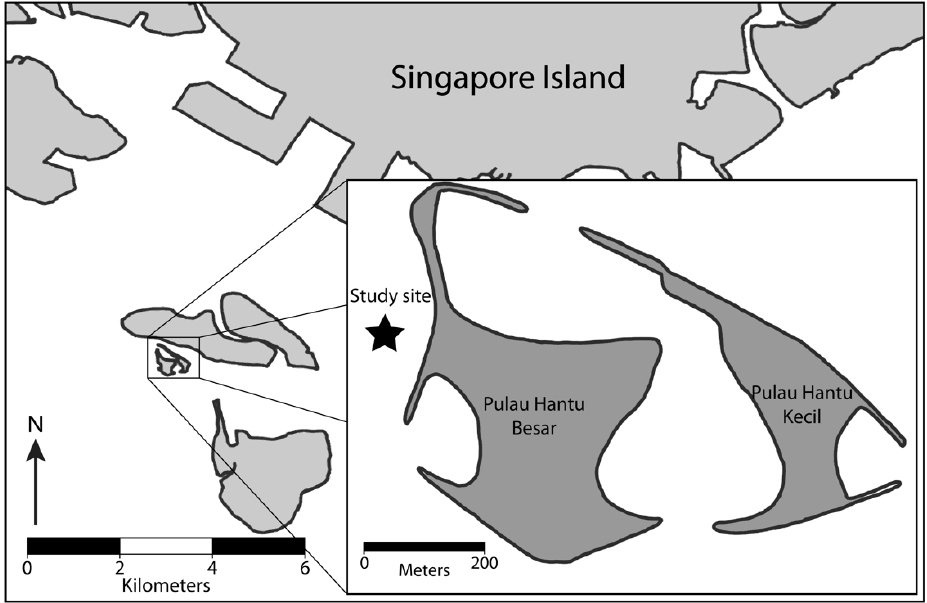
Figure 1. Map of study site (black star), located at the westward facing coastline of Pulau Hantu